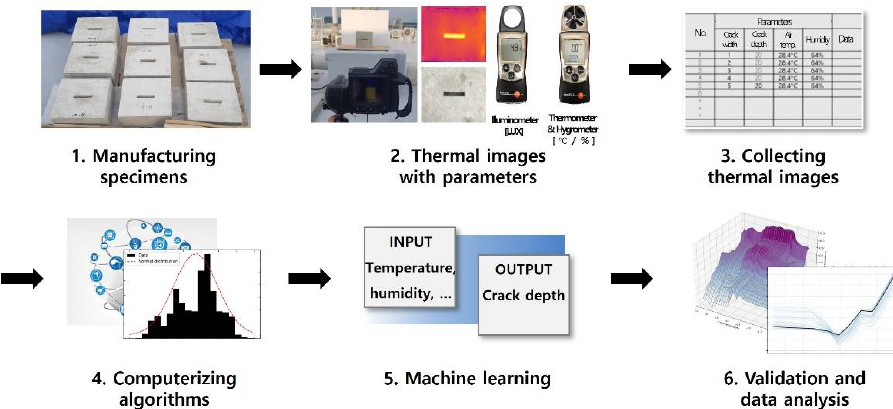
Figure 1. The procedure of machine learning with thermal images.